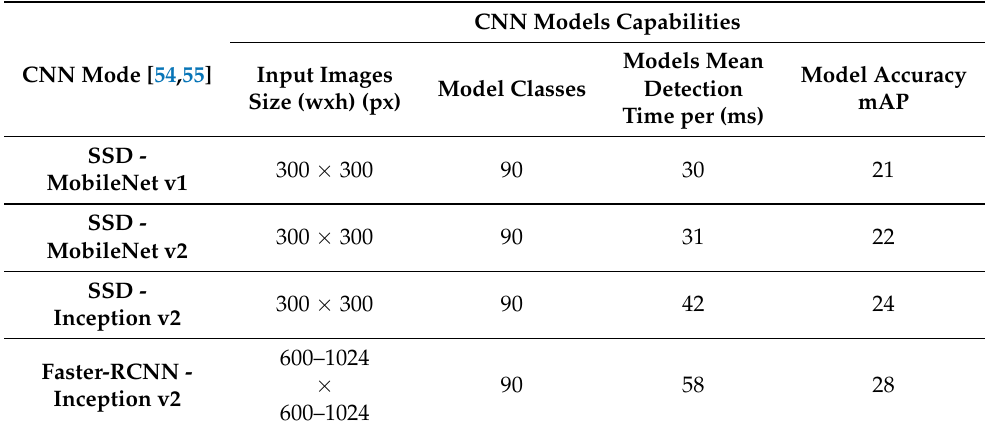
Table 2. CNN models used during the training